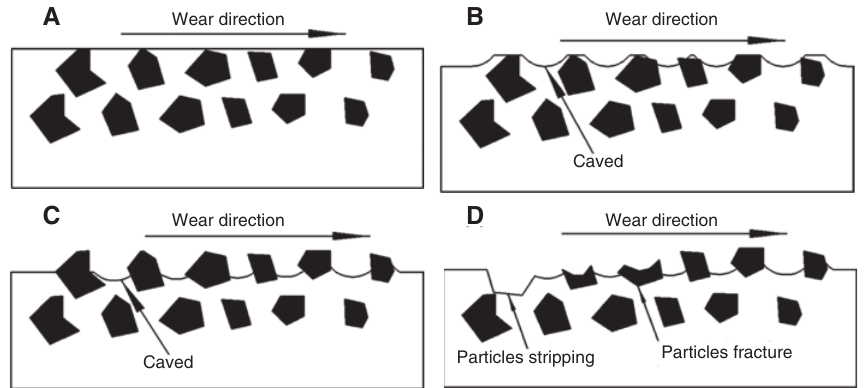
Figure 16: Schematic diagrams of the composite wear